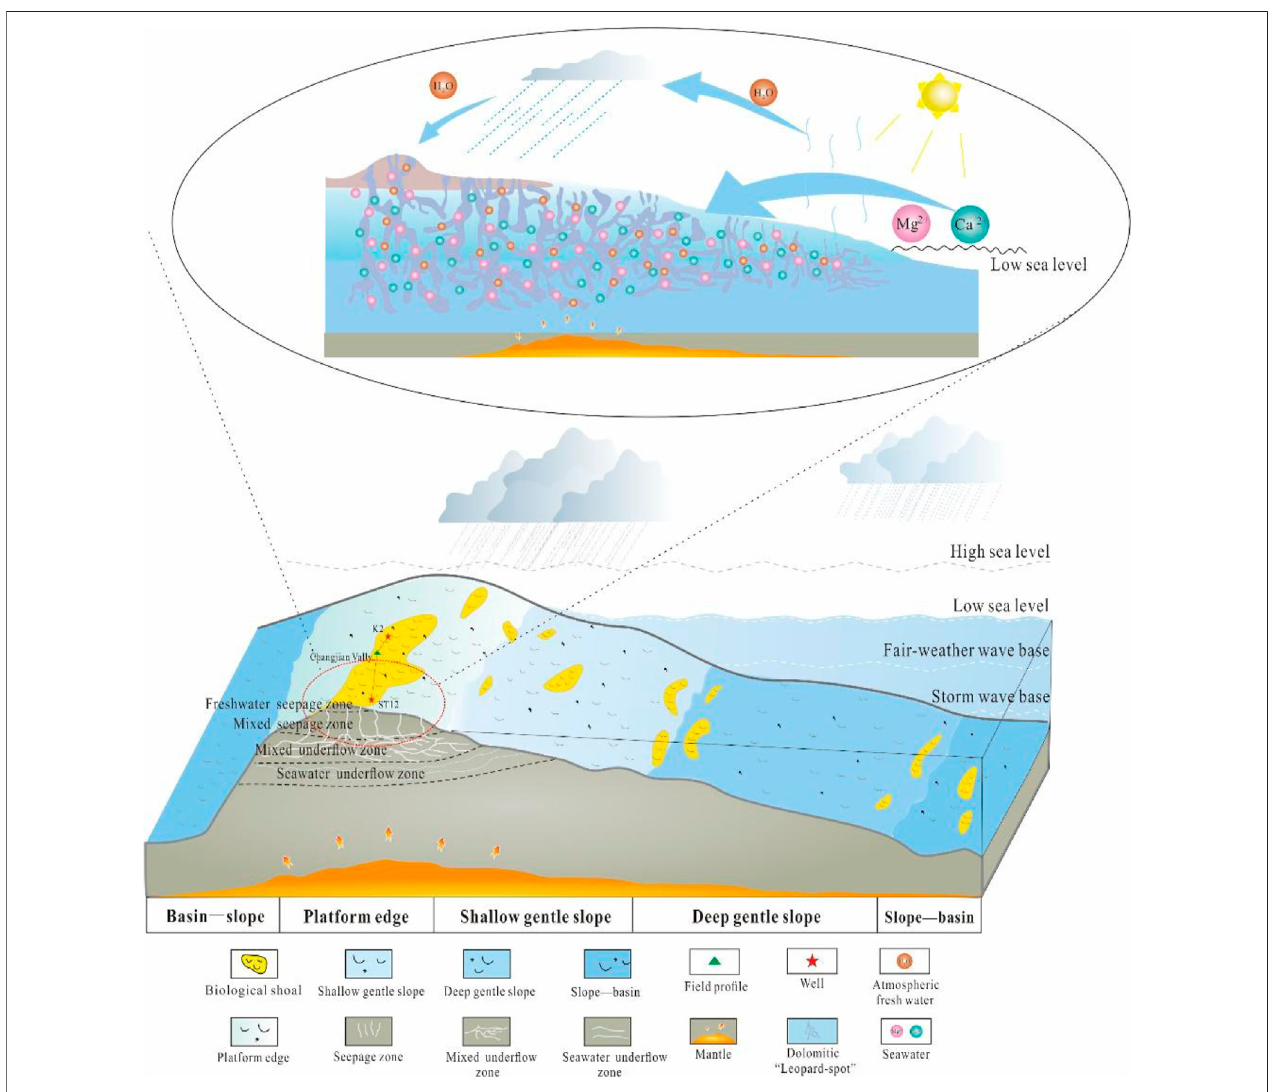
FIGURE 8 | Schematic diagram of diagenetic fl uid migration and diagenetic model in the study area.